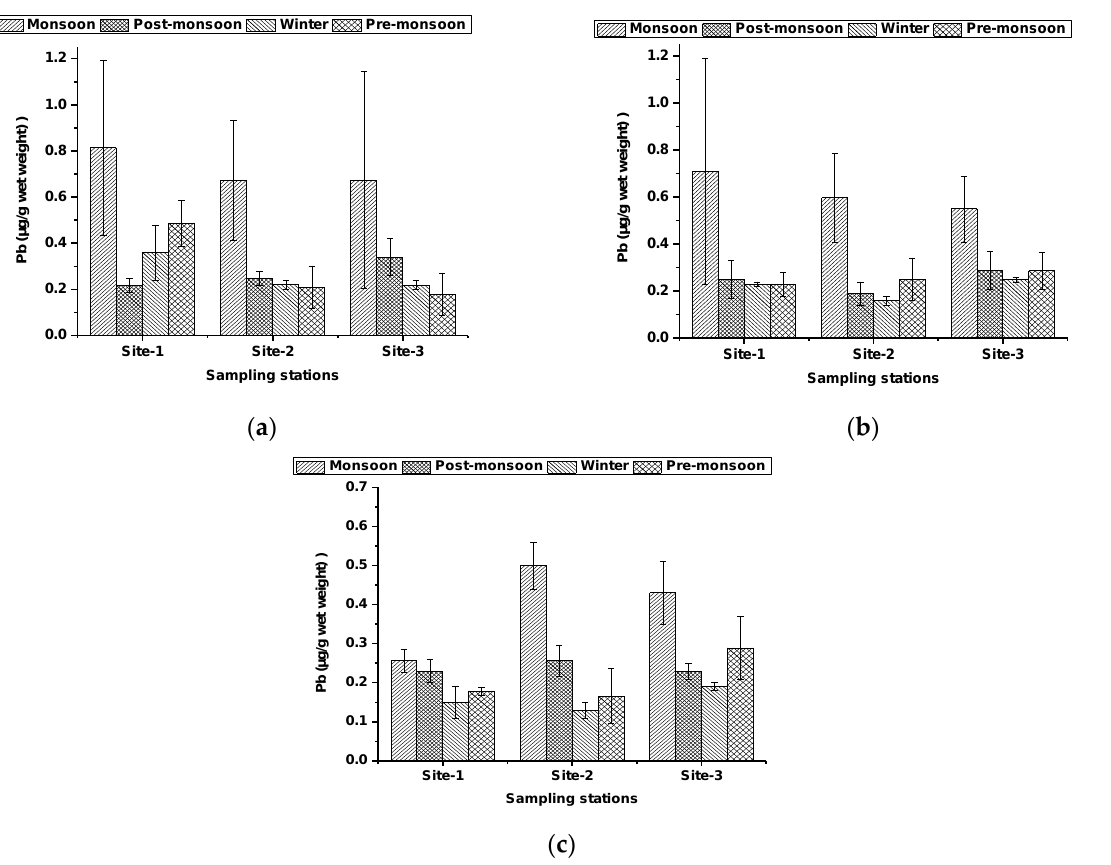
Figure 2. ( a ) Concentrations of Lead (Pb) in L. rohita fish species; ( b ) Concentrations of Lead (Pb) in C. cirrhosus fish species; ( c ) Concentrations of Lead (Pb) in L. calbasu fish species.